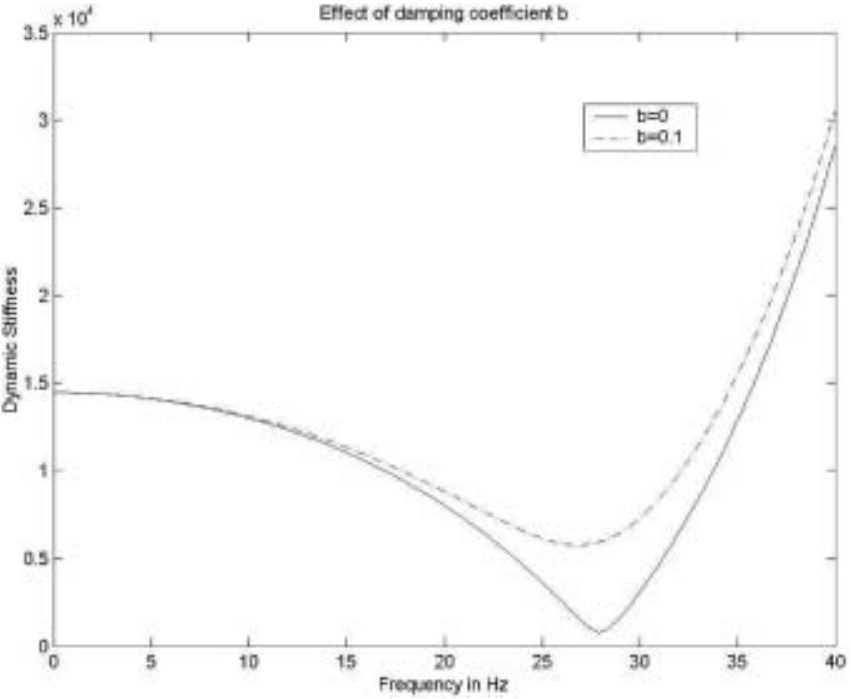
Fig. 7. Effect of Damping Coefficient, b, on Dynamic